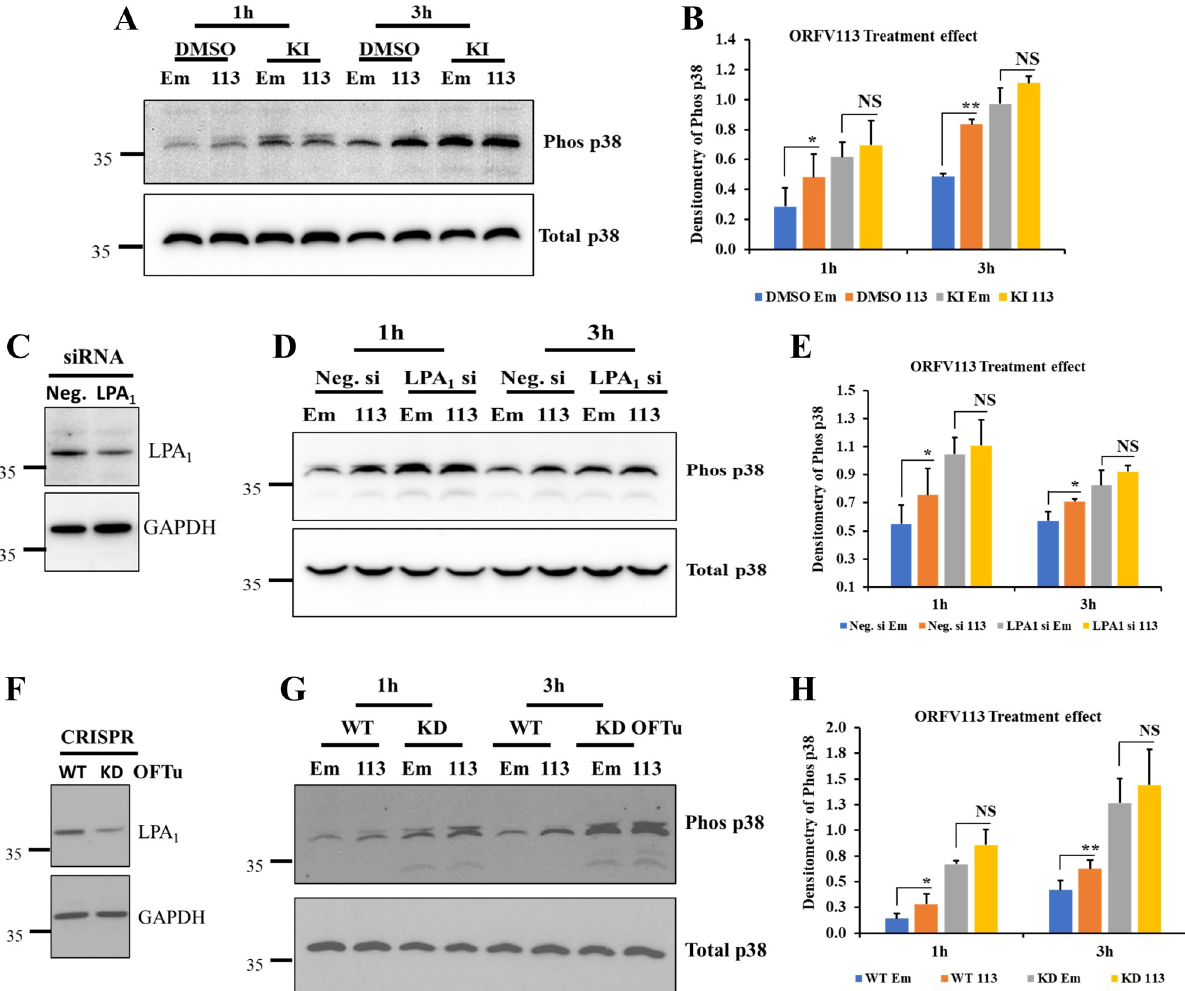
Fig 7. LPA 1 is involved in ORV113 induced p38 phosphorylation. (A and B) Inhibiton of LPA 1 blocks ORFV113 induced p38 activation. OFTu cells pretreated with DMSO (vehicle control) or KI16425 (LPA 1 inhibitor) (10 μ M) for 45 min were treated with immunoprecipitation products from pCMV-HA or pORFV113 HA expressing cells in presence of DMSO (vehicle control) or 10 μ M KI16425 and harvested at 1 and 3 h post treatment. Total cell protein extracts were resolved by SDS-PAGE, blotted and incubated with antibodies against phos-p38 and total p38. (B) Densitometry of phos-p38 bands were normalized to total p38 (loading control). Results are average of three independent experiments. Error bars represent mean ± SD. Statistical analysis was performed using paired Student’s t-test ( � , P < 0 . 05 ; �� , P < 0 . 01 , NS : non-significant ). (C, D and E) Effect of LPA 1 receptor knockdown on ORFV113-induced p38 activation. OFTu cells transfected with universal negative control siRNA (Neg.) or with pooled LPA 1 siRNA (100 nM) for 24 h were either harvested or treated with immunoprecipitation products from pCMV-HA or pORFV113 HA expressing cells and harvested at 1 h and 3 h. (C) To measure the LPA 1 knockdown in siRNA-treated cells, total cell protein extracts were resolved by SDS-PAGE, blotted and incubated with antibodies against LPA 1 and GAPDH. Densitometry of LPA 1 bands were normalized to the loading control GAPDH. Approximately 45% LPA 1 knockdown was routinely observed compared to universal negative control siRNA treatment. (D) To assess the effect of siRNA LPA 1 knock down on ORFV113 induced p38 activation, total cell protein extracts were resolved by SDS-PAGE, blotted and incubated with antibodies against phos-p38 and total p38. (E) Densitometry of phos-p38 bands were normalized to the loading control total p38. Results are average of four independent experiments. Error bars represent mean ± SD. Statistical analysis was performed as described above ( � P < 0 . 05 , NS : non- significant ). (F, G and H) Effect of CRISPR LPA 1 receptor knockdown on ORFV113 induced p38 activation. Wild type (WT) and CRISPR knock down (KD) OFTu cells cultured for 16 h were either harvested or treated with immunoprecipitation products from pCMV-HA or pORFV113 HA expressing cells and harvested at 1 h and 3 h. (F) LPA 1 knockdown was measured as in C. Approximately 50% LPA 1 knockdown was routinely observed. (G) The effect of LPA 1 knockdown on ORFV113-p38 activation was assessed as in D. (H) Results are average of four independent experiments. Error bars represent mean ± SD. Statistical analysis was performed as described above ( � , P < 0 . 05 ; �� , P < 0 . 01 , NS : non-significant